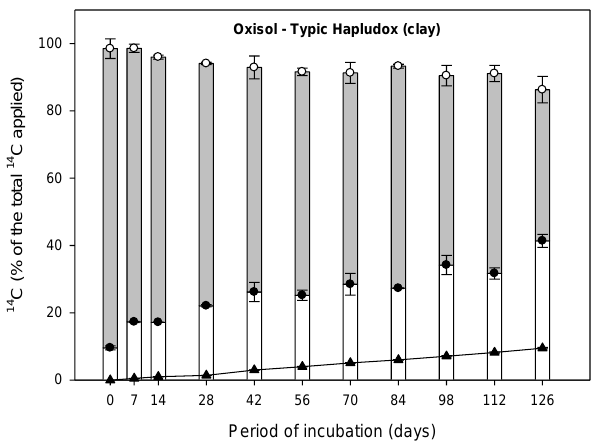
Figure 1. Distribution of 14 C-aminocyclopyrachlor in soil among extractable residues with solvent, mineralized 14 C-CO 2 , and bound residues as a function at the 126 days of incubation time in three Brazilian soil samples. Standard deviation of means ( n = 3) are shown for the extractable residue (white circle) and for the bound residue (black circle).